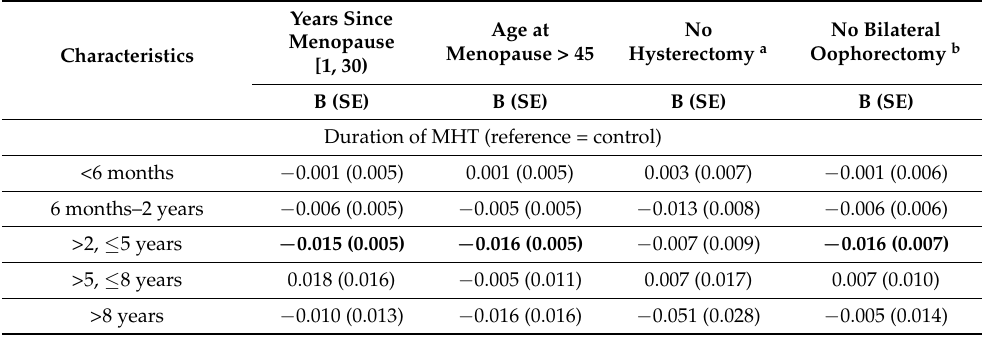
Table 6. Associations between MHT-related information and frailty (IPTW regression analysis,